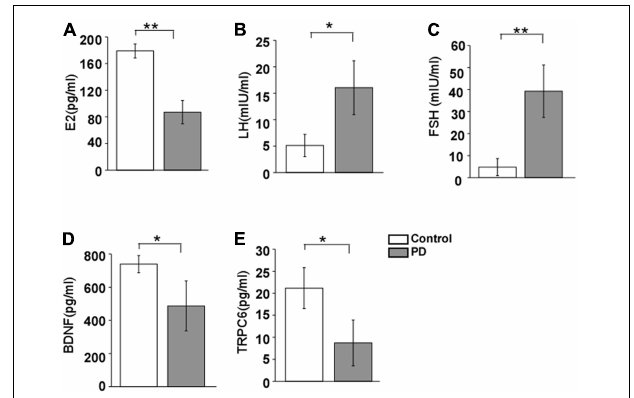
FIGURE 1 | Changes in the E 2 (A) , LH (B) , FSH (C) , BDNF (D) , and TRPC6 (E) levels in serum in PD women and age-matched control women ( n = 20, each group). E 2 , estradiol; FSH, follicle-stimulating hormone; and LH, Luteotropic hormone. Results are presented as mean ± SEM. * p < 0.05; ** p <